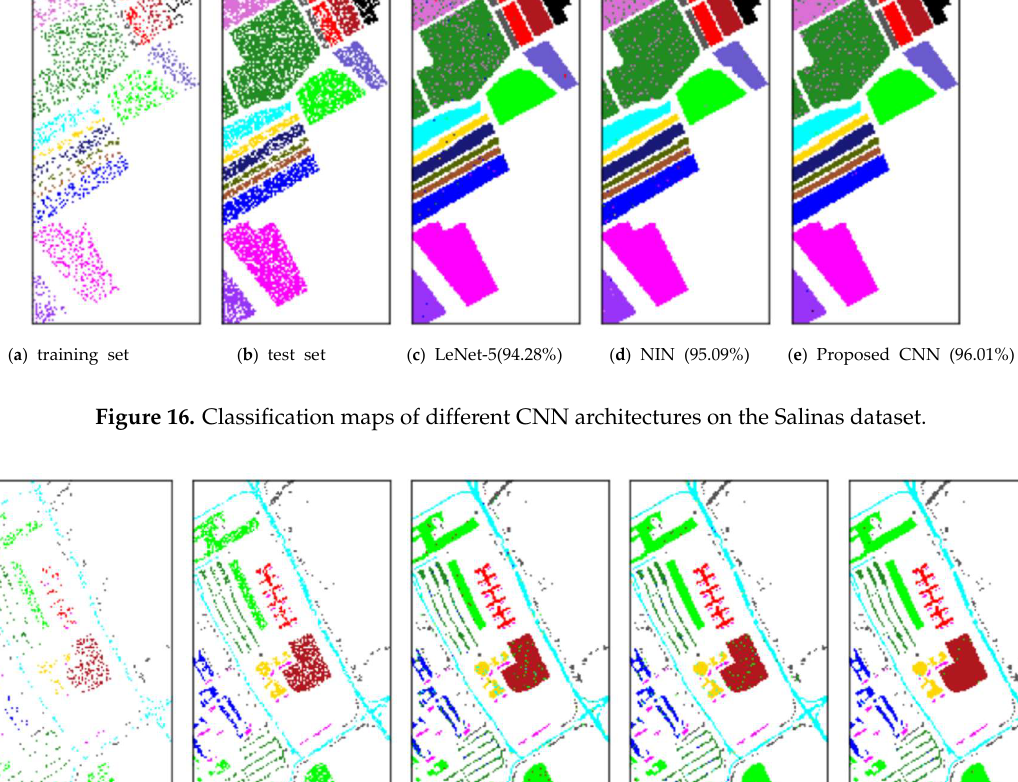
Figure 15. Classification maps of different CNN architectures on the Indian Pines dataset.